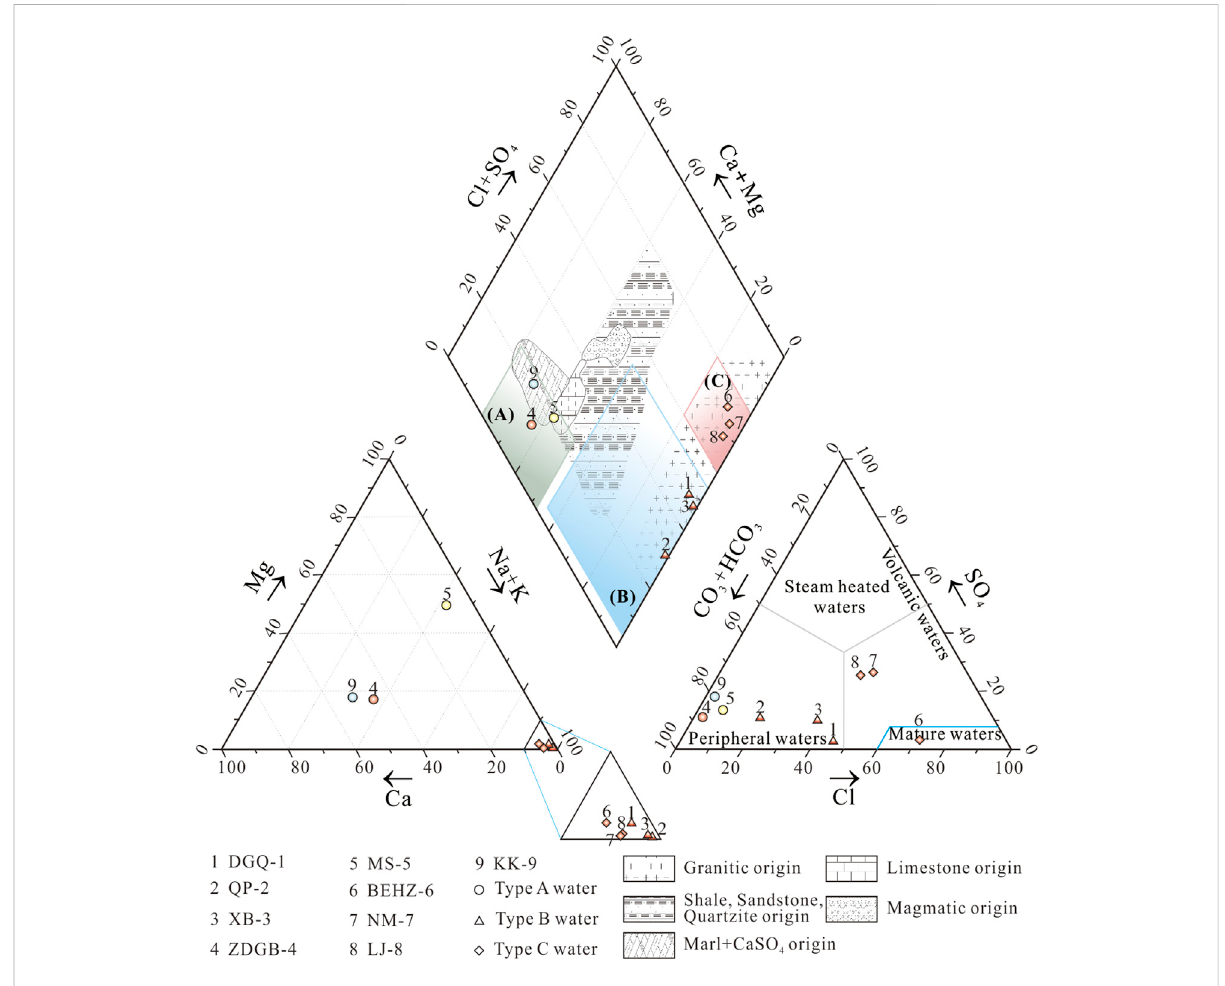
FIGURE 2 Piper diagram to recognise the hydrogeochemical facies in spring water samples from the KKF. Cl – SO 4 – HCO 3 triangular diagram in the lower rightcornerofPiperdiagram(basedonNicholson,1993).Therock fi eldinthePiperdiagramwasadoptedfromZuurdeegandVanderWeiden(1985) andAppeloandPostma(2004).Thelegend fi lledblue,yellow,andredcolorrepresentthetemperaturesatthespringventbelow25 ° C,between25 ° C and 50 ° C, and above 50 ° C of spring water samples,